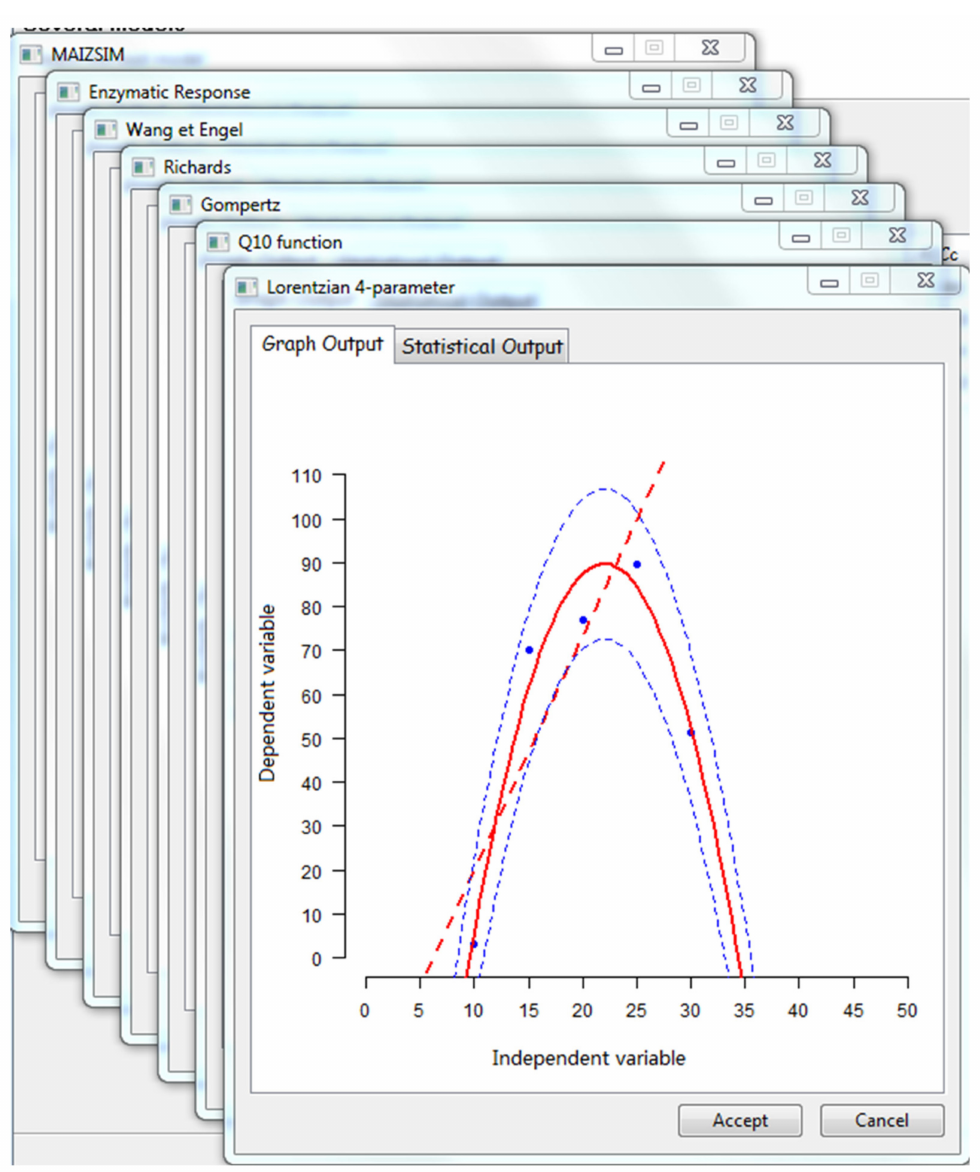
Figure 6. Display of all the fitted equations for the selection of the